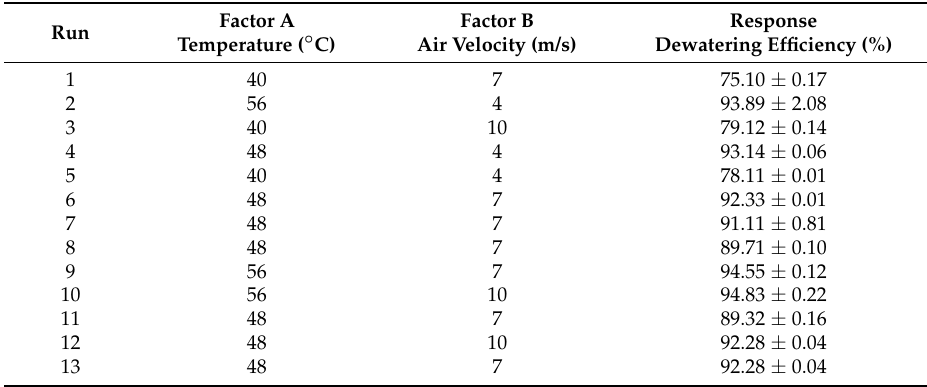
Table 2. Design Matrix and measured dewatering efficiency